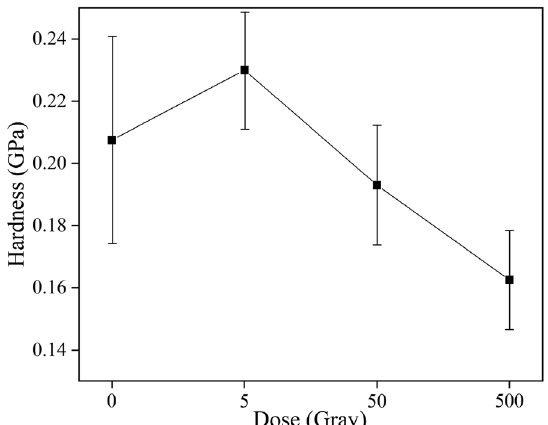
Figure 8 Graph of averaged hardness calculated from indentation test for control (0 Gy) and irradiated samples (5, 50, 500 Gy) [53]